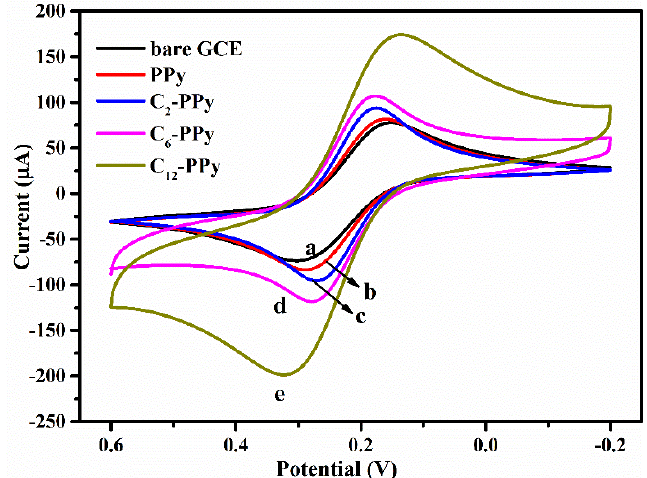
Figure 3. Cyclic voltammograms of the modified electrodes in 0.01 M PBS containing 5 mM Fe[(CN) 6 ] 3 − /4 − and 0.1 M KCl (pH 7.0) ( a ) bare GCE; ( b ) PPy/GCE; ( c ) C 2 -PPy/GCE; ( d ) C 6 -PPy/GCE and ( e ) C 12 -PPy/GCE.